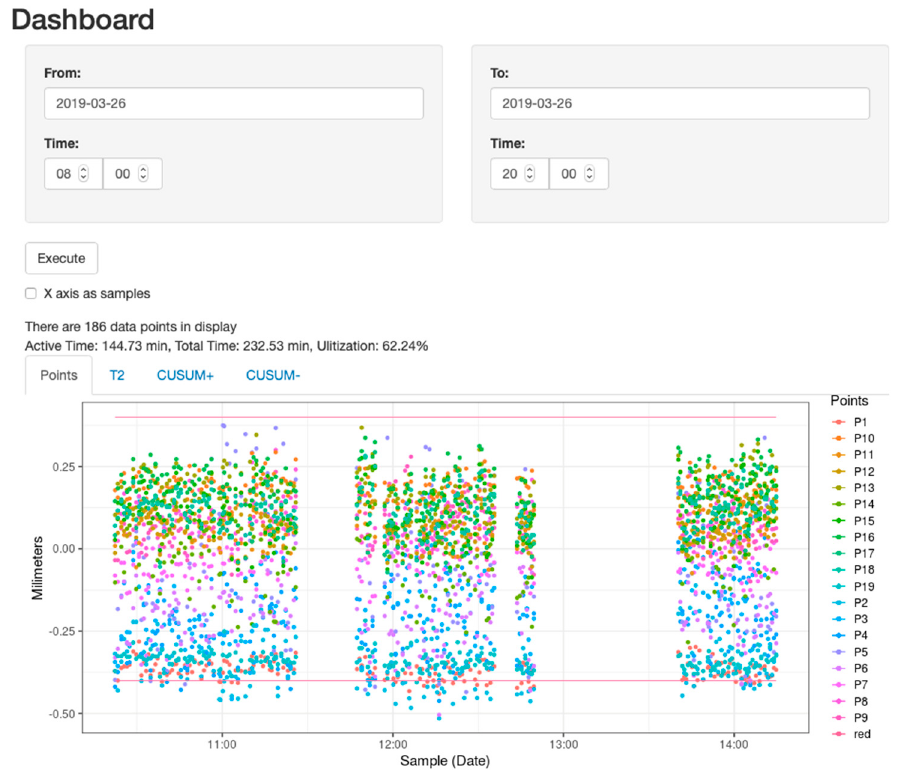
Figure 12. Dahsboard for monitoring machine utilization and operation times. Points correspond to measurements at a given time.